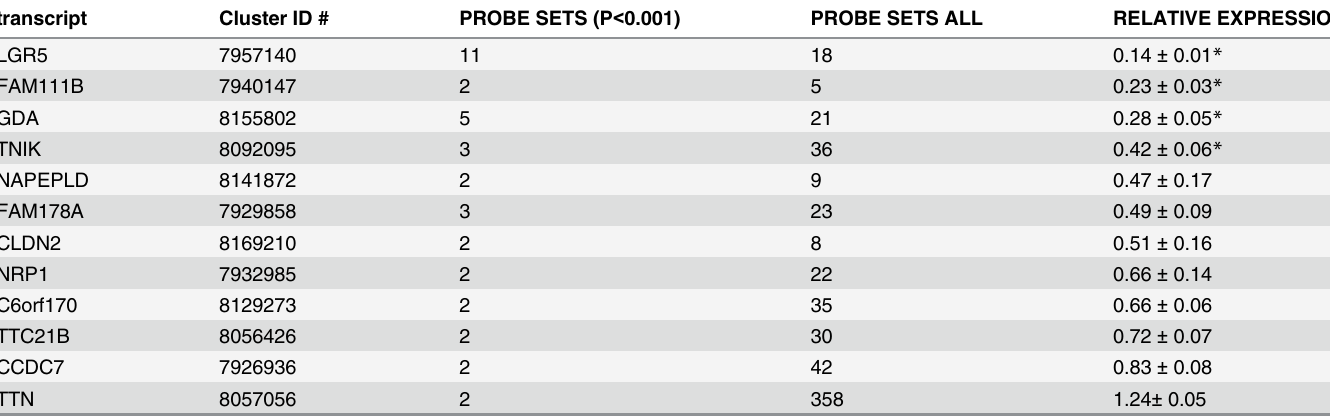
Table 2. Transcripts reduced at the permissive temperature at a minimum of 2 probe sets.